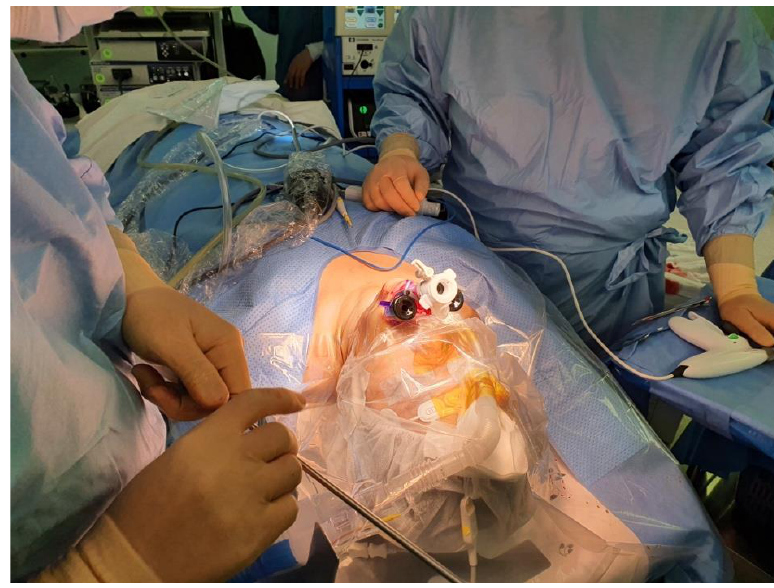
Figure 3. Incision sites for transoral vestibule